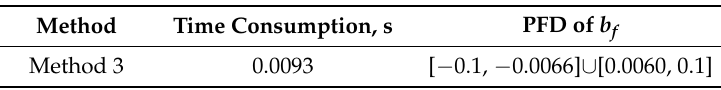
Table 5. Results of Method 3 for the 3-bus benchmark.